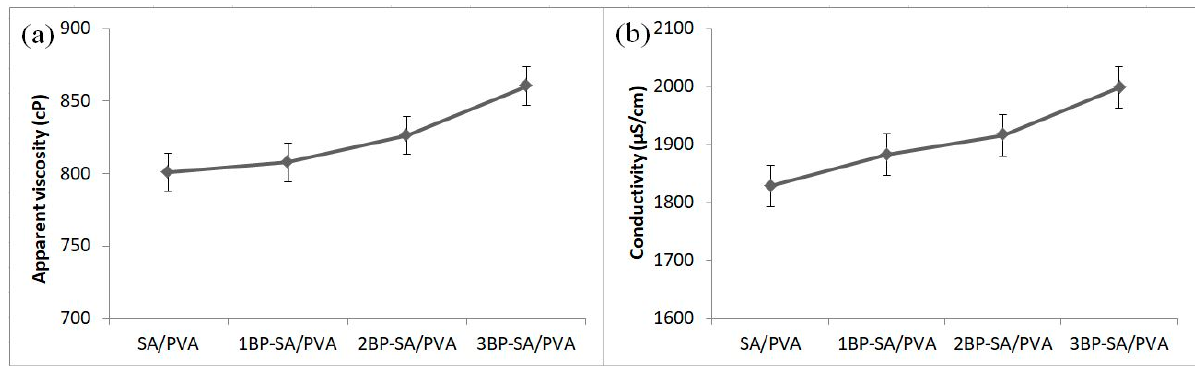
Figure 2. Apparent viscosity ( a ) and conductivity ( b ) of the electrospinning solutions with varying bee pollen content: 0, 1, 2, and 3 weight %.